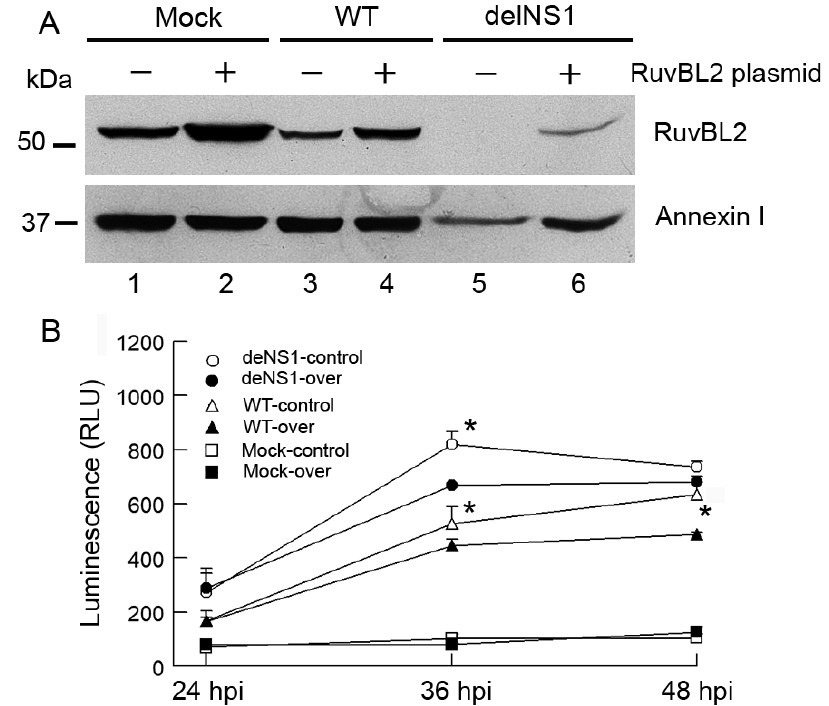
Figure 7. Overexpression of RuvBL2 promotes resistance to infection-induced apoptosis. Vero cells were transfected with an empty vector (control) or a plasmid that expressed RuvBL2, and the transfected cells were then mock-infected or infected with WT or delNS1 PR8 virus at an MOI of 1. The cells were either harvested at 36 hpi for Western blot analysis ( A ), or at the indicated time points for measurements of caspase 3/7 activities ( B ). Values in ( B ) are the means ± SE of three separate sample preparations. * denotes p < 0.05 and indicates the statistical differences between the cells that overexpressed RuvBL2 (over) and the corresponding control cells that did not overexpress RuvBL2 (control).